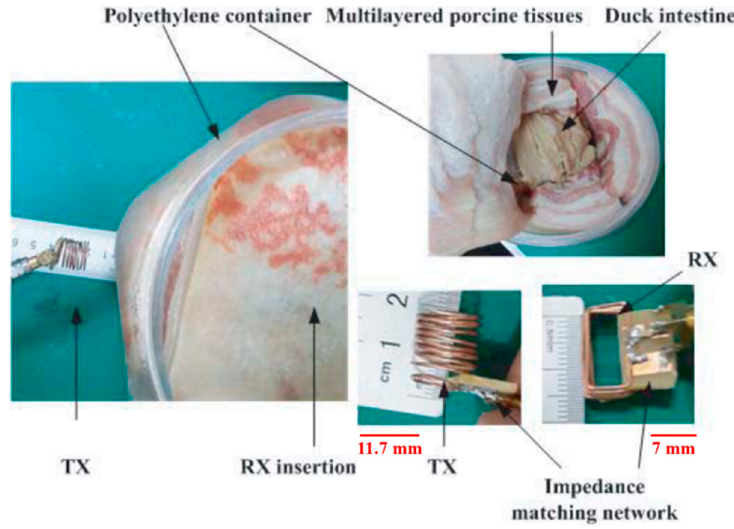
Figure 28. NRMRC WPT sub-GHz experimental setup [149]. Reproduced with permission of Electromagnetics Academy. Electromagnetics